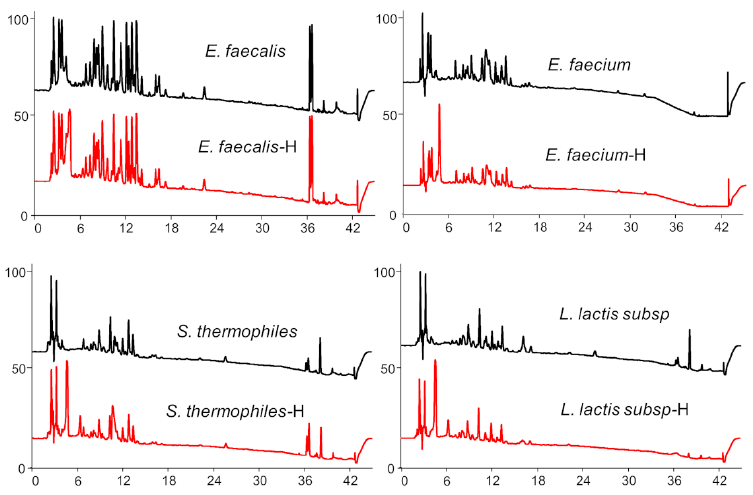
Figure 5. Comparison of metabolic profiles of four strains, E. faecalis , E. faecium , S. thermophilus , and L. lactis subsp. Lactis , fed with and without hydroquinone (H, 5 ) in